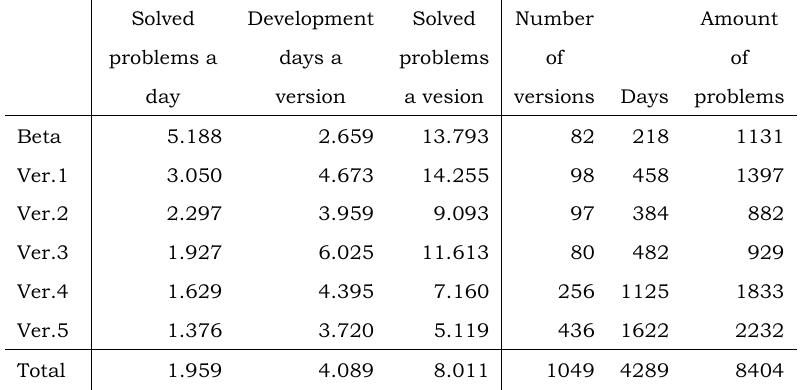
Table 1. Version up history of Hidemaru